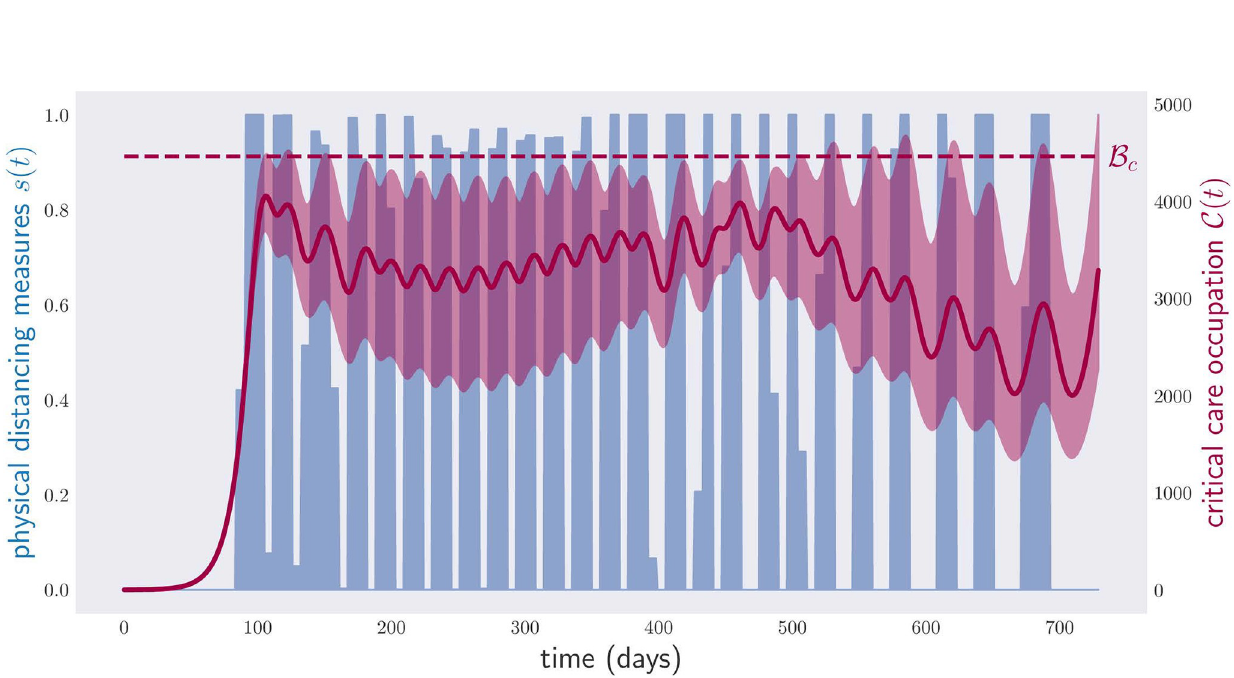
Fig 10. Occupation of critical care beds (red) and (optimized) physical distancing measures (blue) for a period of two years under random parameters in N . The disease control policy was optimized to respect condition (2) over the whole range of parameters N 0 : 05 red depicts again the range of critical care occupations observed in a sample of 1000 model parameters in N